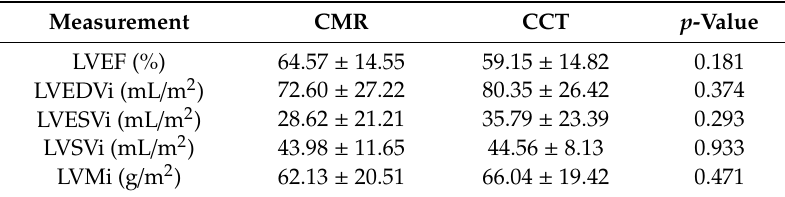
Table 2. Values of volumetric assessment of the LV by CMR and